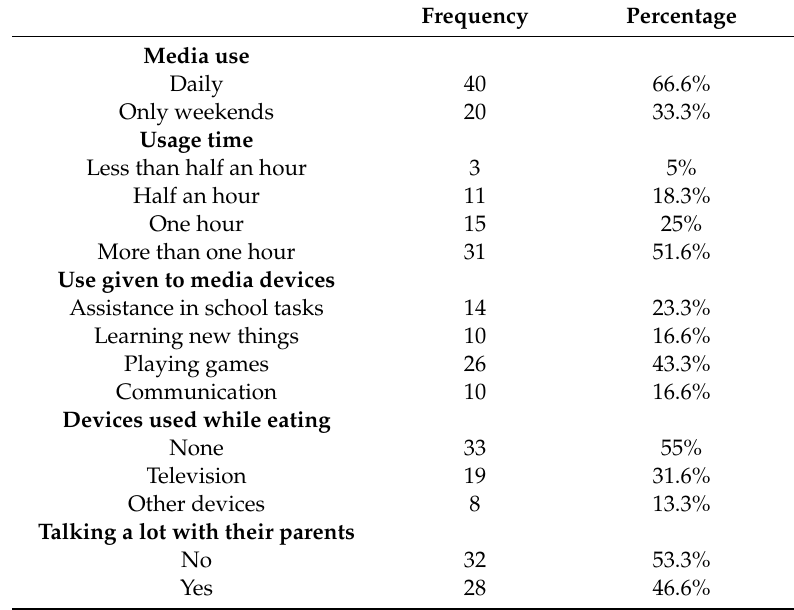
Table 3. Frequency and percentage of media use and communication with